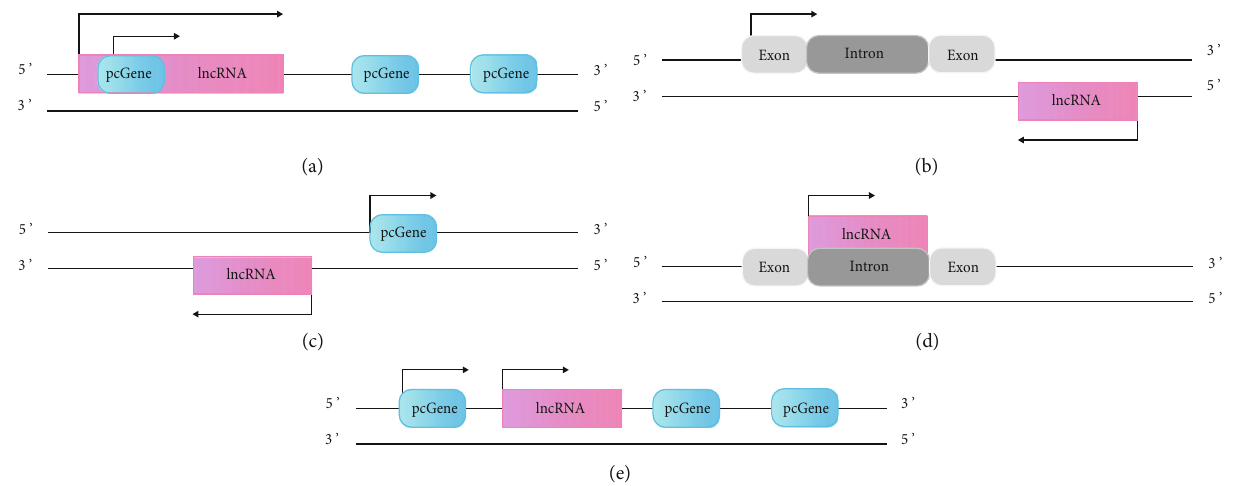
Figure 1: Schematic diagram of lncRNA classi fi cation. Classi fi cation of lncRNAs into fi ve classes: (a) sense, (b) antisense, (c) bidirectional, (d) intronic, and (e)